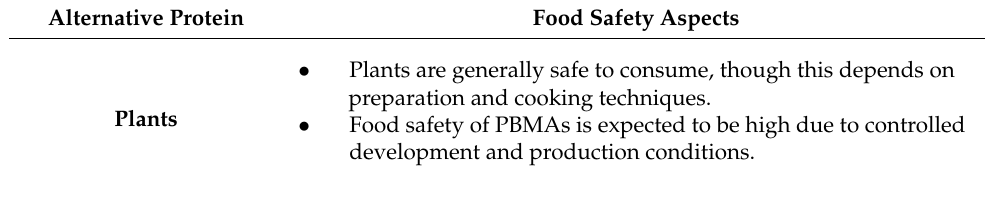
Table 7. Food safety of alternative